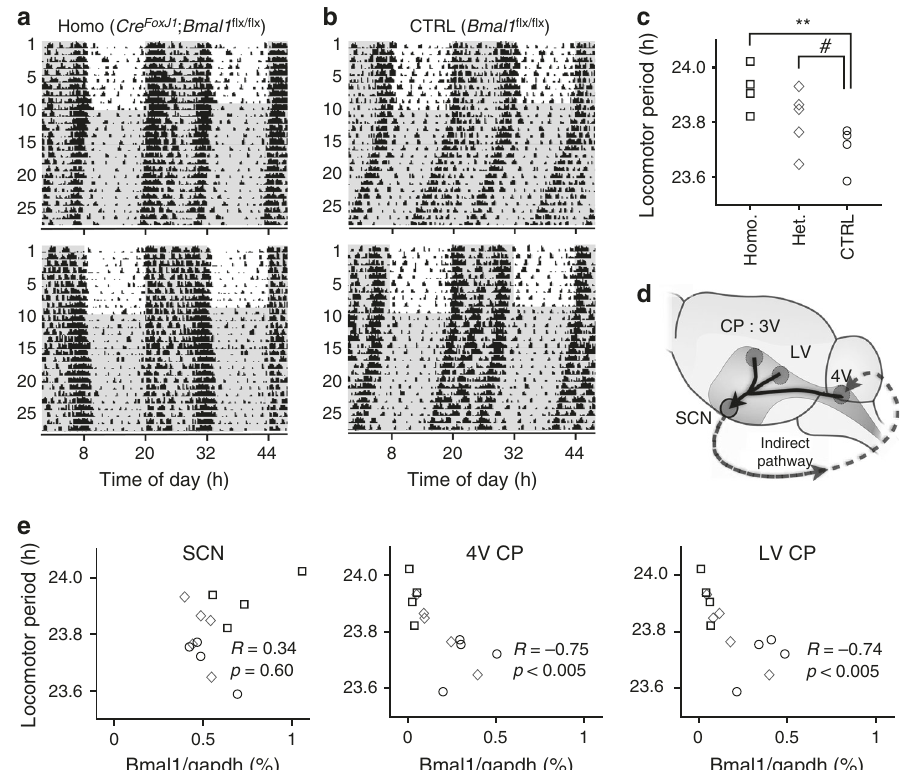
Fig. 6 a Targeted deletion of Bmal1 in the CP lengthens the behavioral circadian period. Two representative double-plotted circadian actograms in mice that lack Bmal1 in the CP. b Two representative double-plotted actograms in congenic controls. c In mice with CP-targeted Bmal1 deletion, the circadian locomotor period becomes signi fi cantly longer than the control, which is the same as the wild type C57BL/6J (23.7 h) (homozygous knockdown (Homo., n = 4; open squares) against control (CTRL, n = 4; open circles): ** p < 0.01; heterozygous knockdown (Het., n = 5; open diamonds) against control (CTRL): # p = 0.066, Welch ’ s t -test). d A hypothetical diagram for connection between the CP and the SCN. The CP is likely to tune the SCN through the CSF, while the SCN relays the light signal to the CP by a non-CSF-mediated pathway. e In the SCN, expression of the Bmal1 transcript is unaffected by the CP-speci fi c Cre recombinase FOXJ1-Cre and is independent of the behavioral locomotor period. In both 4V CP and LV CP, Bmal1 expression is close to null in the animals expressing FOXJ1-Cre. In control littermates, Bmal1 expression varied, but was higher than zero. This makes an inverse correlation between Bmal1 expression and the locomotor period (Pearson ’ s correlation coef fi cient). Open squares, diamonds, circles indicate samples from the same animals in